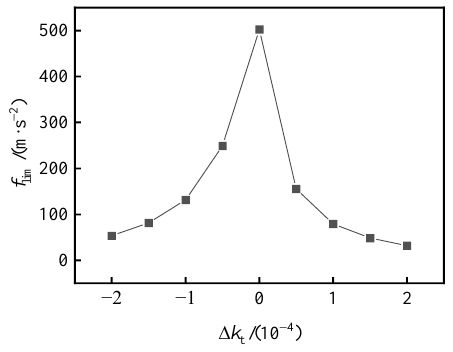
Figure 11. Overload limit versus taper error.